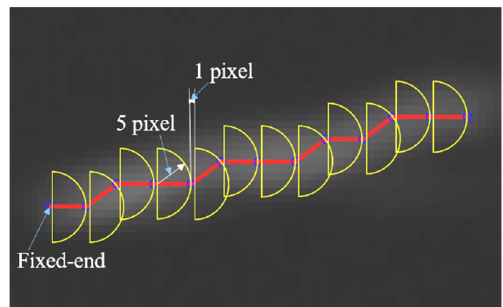
Figure 5. Single mini-tuft recognition example.